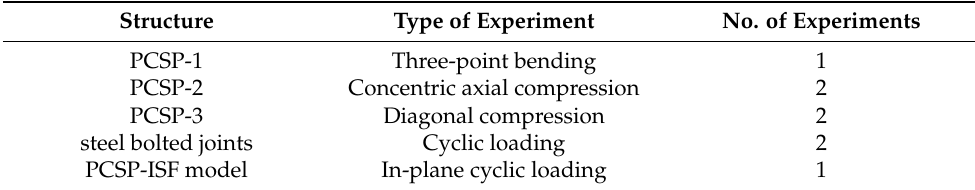
Table 1. Summary of the experimental